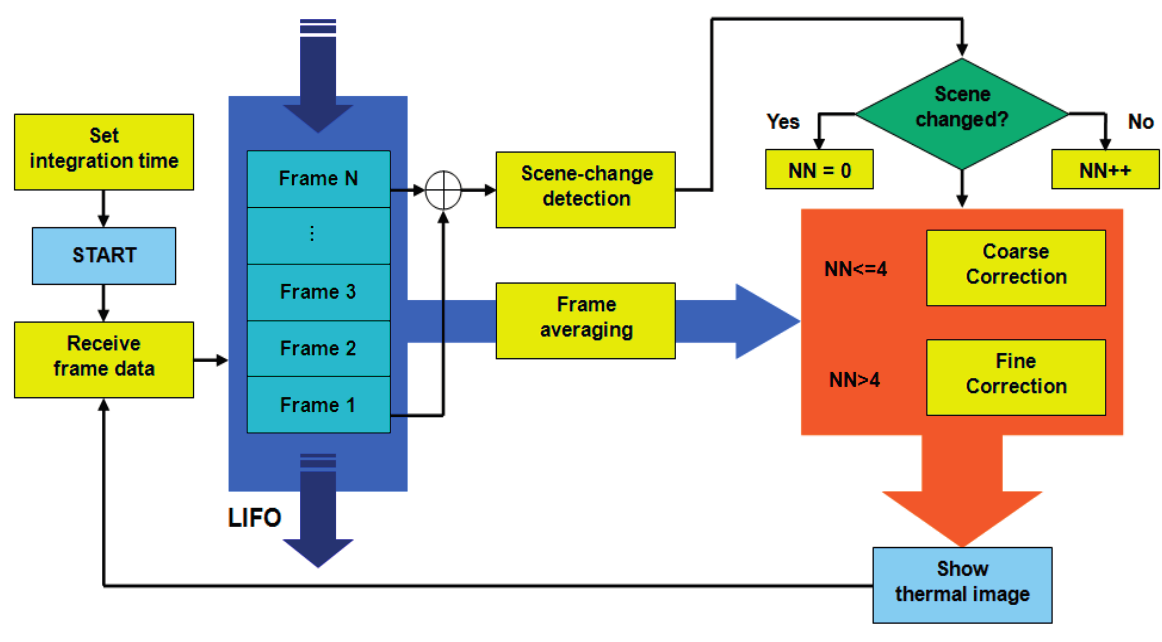
Figure 5. The IRAPP diagram